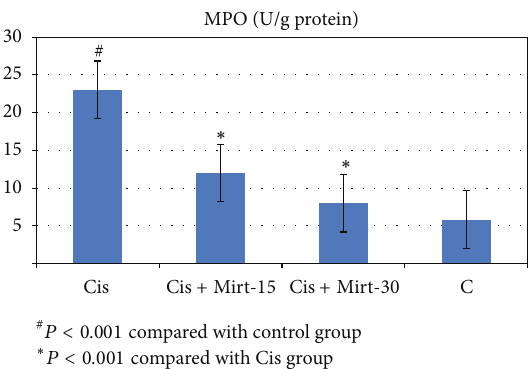
Figure 2: MPO activity of study groups.